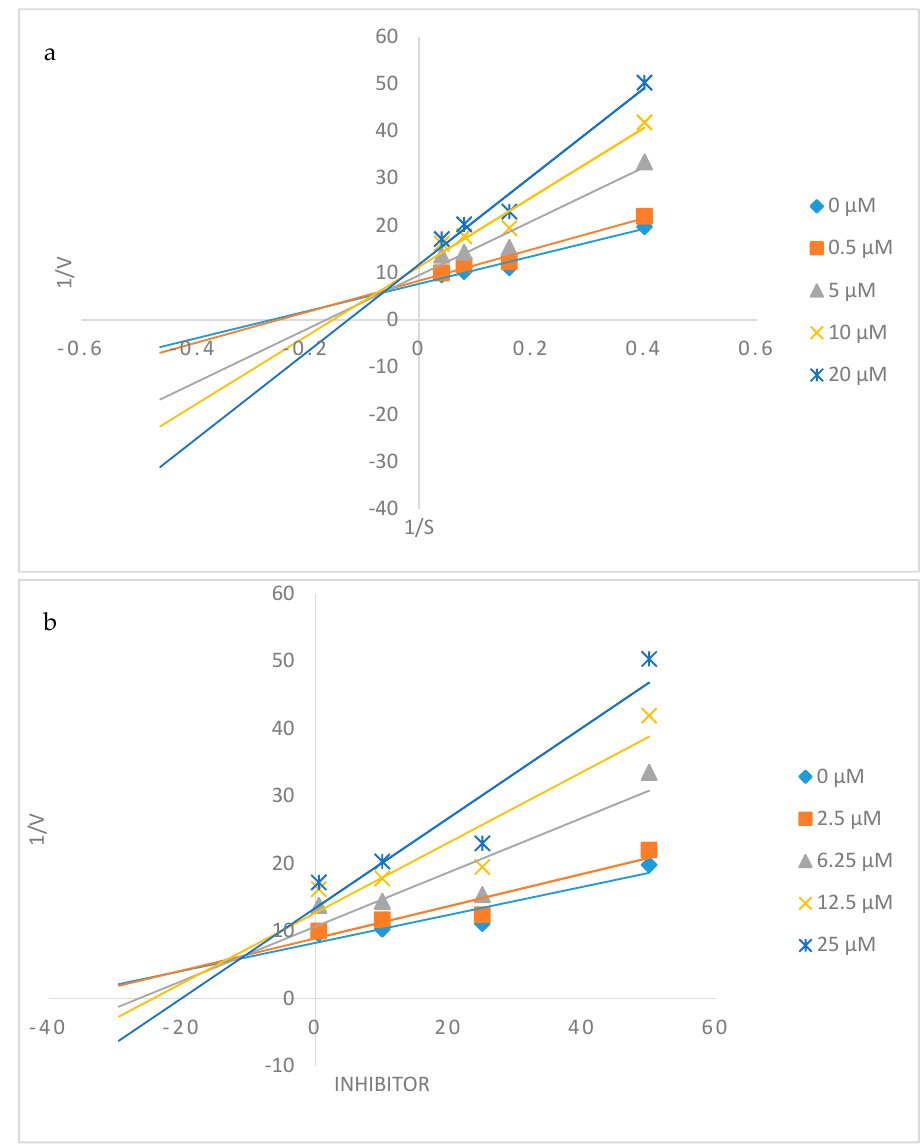
Figure 3. Lineweaver–Burk ( a ) and Dixon ( b ) plots for the inhibition of α -glucosidase by 2h . The Lineweaver-Burk (Figure 4a) and Dixon (Figure 4b) plots of compound 2c for the inhibition